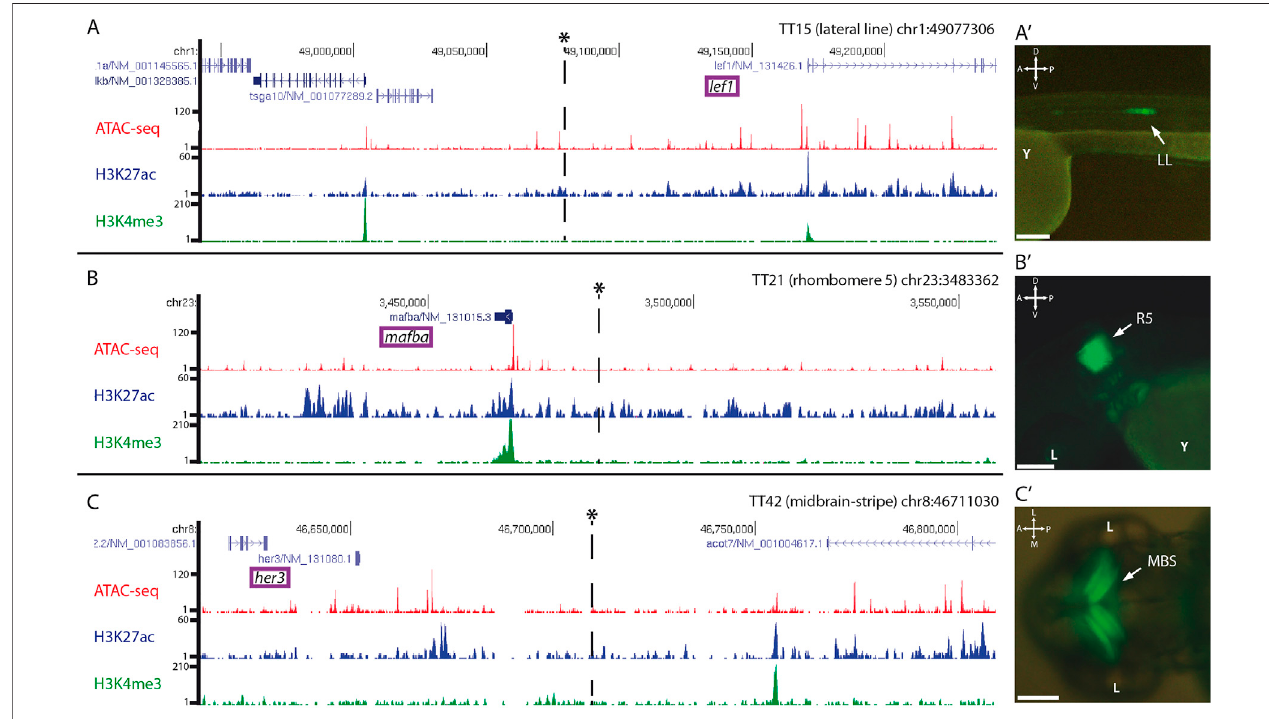
FIGURE 3 | Genomic insertion sites of trap:TRAP cassette in representative transgenic lines : Insertions are marked with an asterisk*. Tracks for ATAC-seq, H3K27ac and H3K4me3 at 48 hpf are also shown for the different loci. (A) : Genomic location of the insert in the transgenic line TT15 in the vicinity of lef1 , (A 9 ) : TT15 expressionpatternat48 hpf. (B) :GenomiclocationoftheinsertinthetransgeniclineTT21nearby mafba , (B 9 ) :TT21expressionpatternat48 hpf. (C) :Genomiclocation of the insert in the transgenic line TT42, (C 9 ) : TT42expression pattern at 48 hpf.LL, lateral line; R5, rhombomere 5; MBS, midbrain stripe. D-V, dorso-ventral; A-P, anterior-posterior. Scale bar (cid:1) 100 µm.